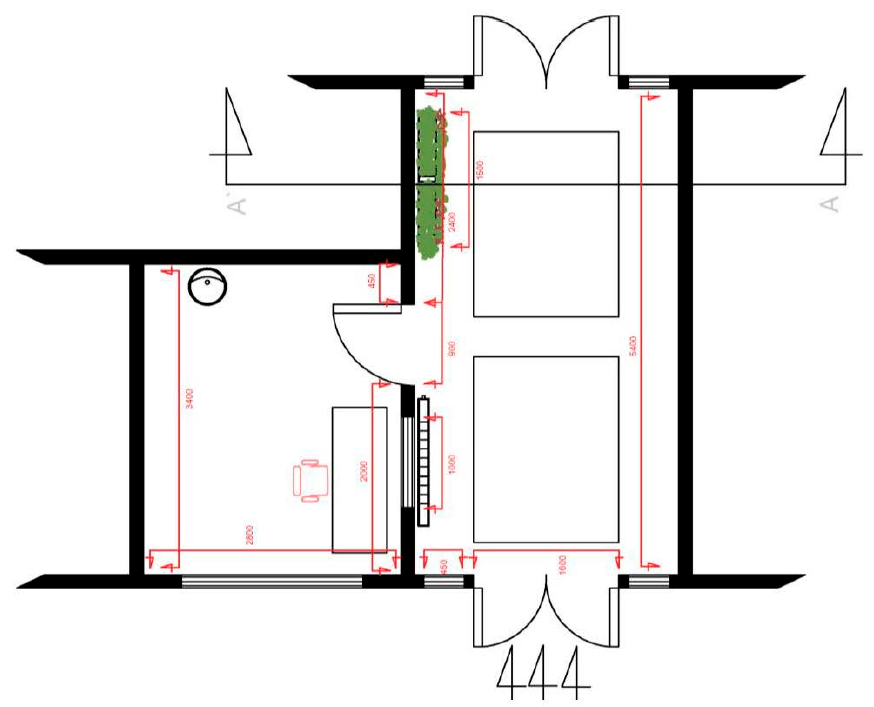
Figure 6. Floor plan of the entrance hall in PK 10- room with the green